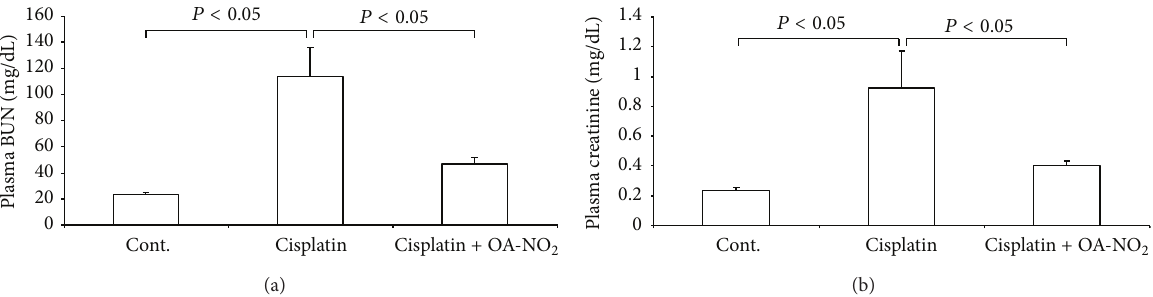
Figure 2: Plasma BUN (a) and creatinine (b) levels in control, cisplatin vehicle, and cisplatin + OA-NO 2 mice. Cont.: 𝑁 = 6 ; cisplatin: 𝑁 = 12 ; cisplatin + OA-NO 2 : 𝑁 = 13 . Data are mean ± SE.